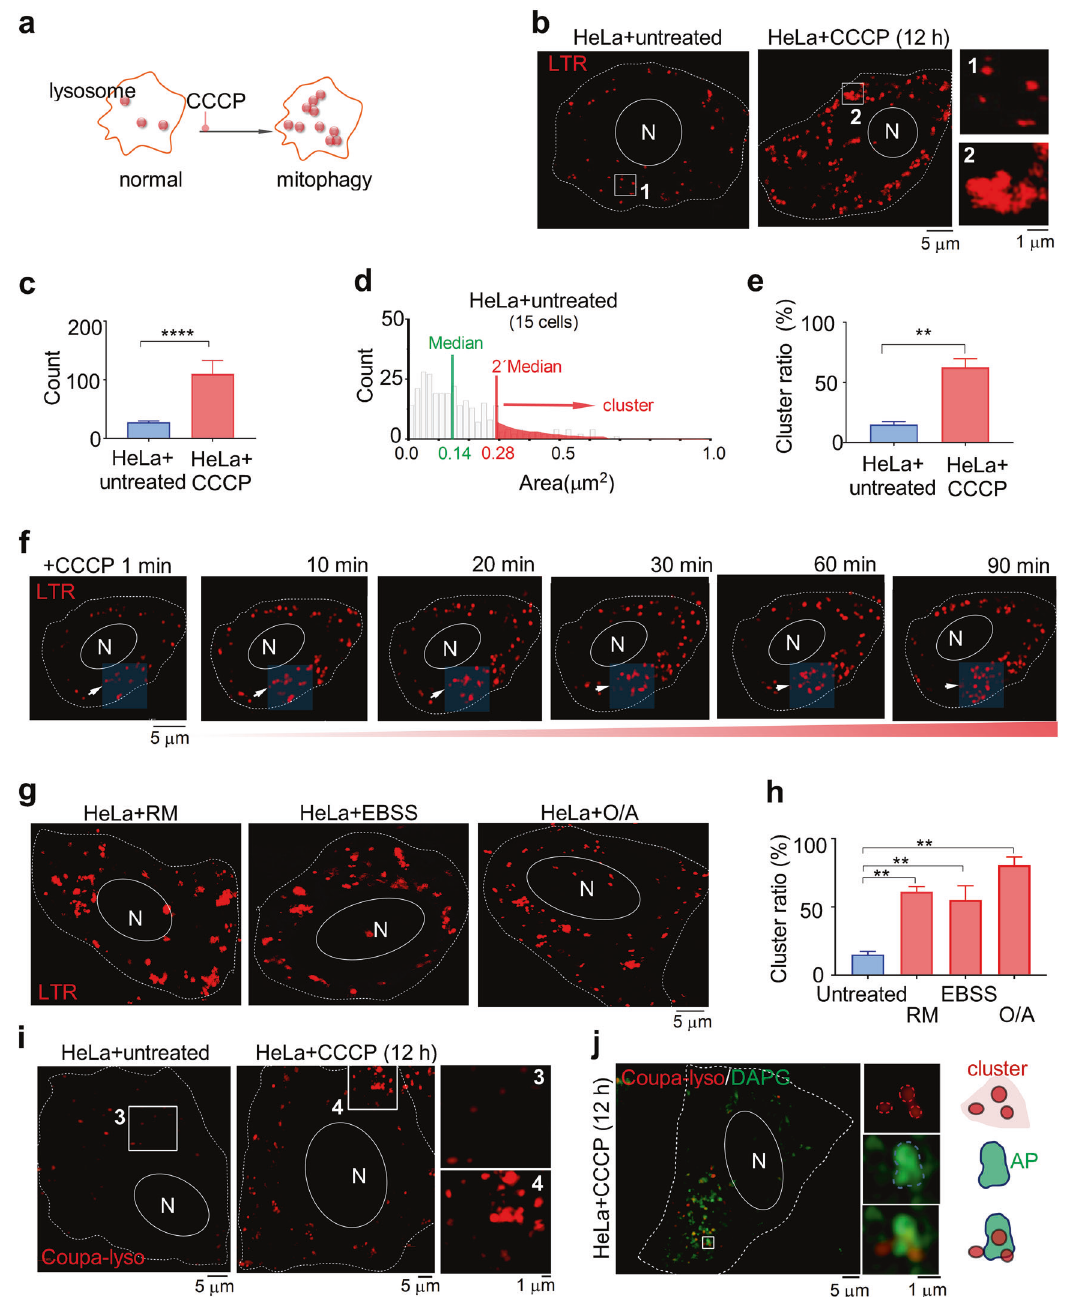
Fig. 1 Super-resolution imaging of lysosome clustering upon stimulation. a Schematic representation of the formation of lysosome clusters in CCCP-induced mitophagy. b Formation of lysosome clusters in HeLa cells with or without CCCP-treated for 12 h. Lysosomes were stained by 200 nM commercial LysoTracker Red (LTR) at 37 °C for 30 min and then observed using SIM. White rectangles 1 and 2 show an enlarged area; white dotted lines indicate cell membranes; N, nucleus. c Lysosome puncta count in HeLa cells with and without CCCP treatment. d Distributions of lysosome areas in untreated HeLa cells. e Ratio of clustered lysosome clusters to the total number of lysosomes in untreated and CCCP-treated HeLa cells. f SIM revealing the dynamic process of the formation of lysosome clusters in CCCP-treated HeLa cells. The white arrow shows a representative dynamic formation of a lysosome cluster. The lower right number indicates the ratio of lysosome clusters to lysosomes. g SIM images and ( h ) quali fi cation of the formation of lysosome clusters in RM-, EBSS-, and O/A-treated HeLa cells. i Speci fi c lysosome probe, Coupa-lyso, was used for revealing lysosome cluster in living cells. Cells were stained with Coupa-lyso without (left) or with (right) CCCP treatment. White rectangles indicate the enlarged region. j CCCP-treated cells co-stained with Coupa-lyso and DAPG, showing lysosome cluster contact with autophagosome. White rectangles indicate representative clustered lysosomes around autophagosome. Data in c , e and h are presented as mean ± SEM, * p < 0.05, ** p < 0.01, *** p < 0.001, **** p < 0.0001.